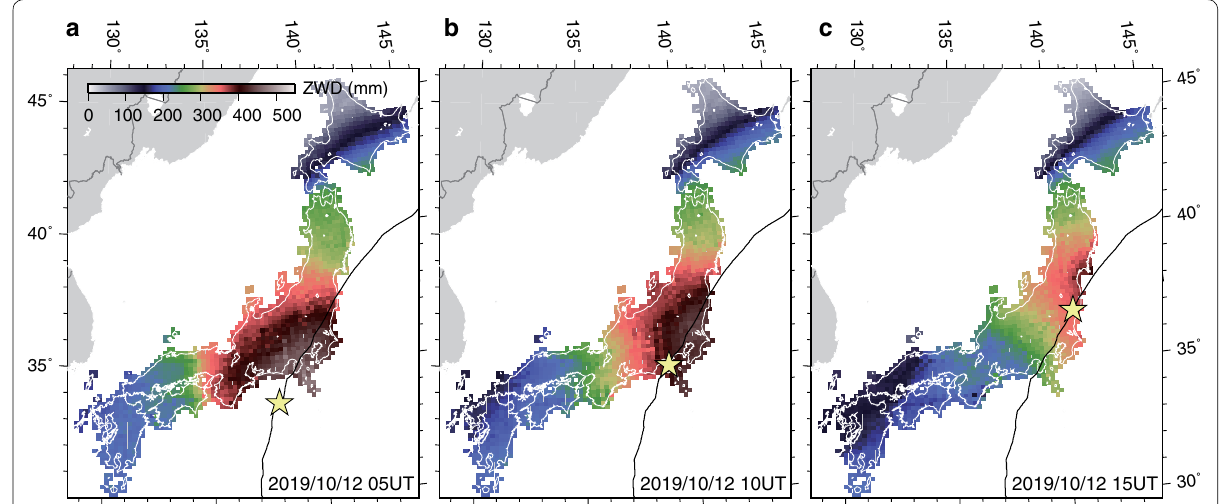
Fig. 8 ZWD during the passage of the 2019 typhoon Hagibis. ZWD on 2019 October 12, when the super-typhoon Hagibis made landfall in the main island of Japan, at epochs a 05 UT (14 JST), b 10 UT (19 JST), and c 15 UT (24 JST). Black curves and yellow stars show the typhoon track and its position at the epoch. We calculated sea level ZWD values using atmospheric delay gradients (Arief S, Heki K. GNSS meteorology for disastrous rainfalls in 2017–2019 summer in SW Japan: a new approach utilizing atmospheric delay gradients, submitted to Frontiers in Earth